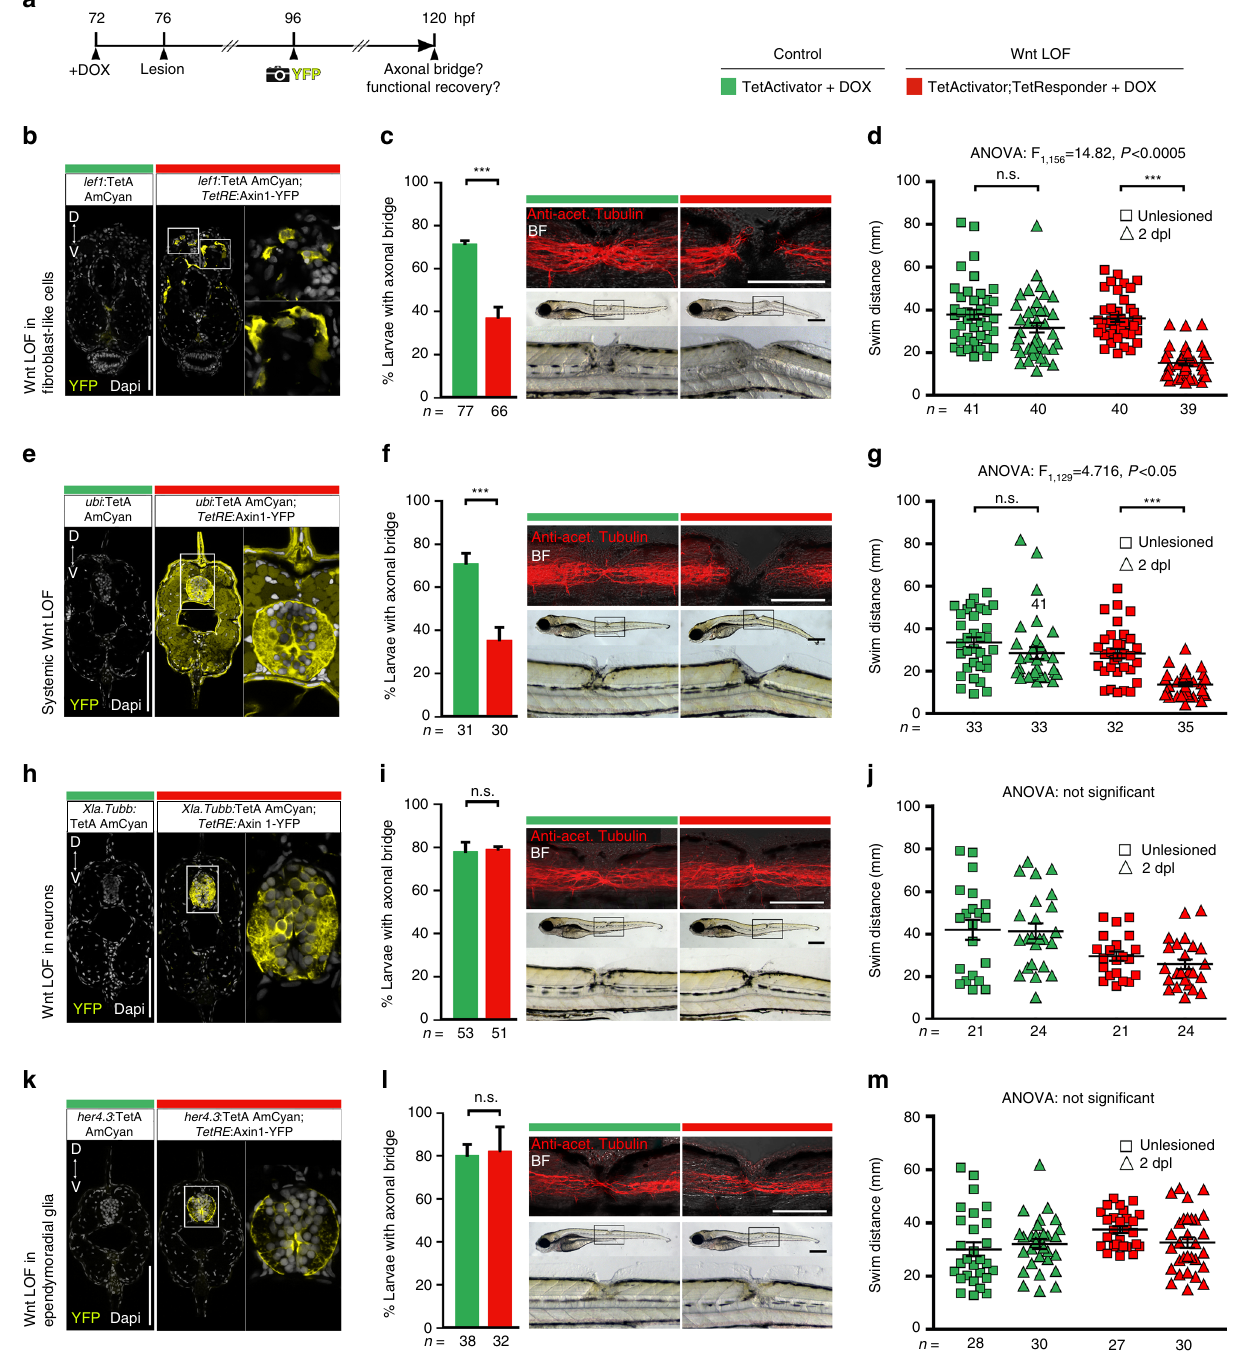
Fig. 3 Wnt/ β -catenin signaling in non-neural cells is required for axon regeneration and functional recovery. a Schematic timeline of the experimental design using the TetON system. b – d axin1 overexpression selectively in cells in the lesion site ( b ; lef1 + ) is suf fi cient to interfere with axon regeneration ( c ; Fischer ’ s exact test: *** P < 0.001) and functional recovery ( d ; two-way ANOVA: F 1,156 = 14.82, P < 0.0005; t -test: *** P < 0.001). e – g axin1 overexpression throughout the fi sh e interferes with axon regeneration ( f ; Fischer ’ s exact test: * P < 0.05) and functional recovery ( g ; two-way ANOVA: F 1,129 = 4.716, P < 0.05; t -test: *** P < 0.001). h – j Neuronal axin1 overexpression, indicated by YFP labelling of parenchymal cell bodies and neuropil in the spinal cord h , does not interfere with axon regeneration i or functional recovery ( j ; two-way ANOVA shows no interaction between lesion and treatment). k – m axin1 overexpression in ependymoradial glial cells, indicated by YFP labeling in cell bodies lining the central canal, their radial processes and pial end feet k does not interfere with axon regeneration l or functional recovery ( m ; two-way ANOVA shows no interaction between lesion and treatment). b – e Views are transversal ( b , e , h , k ; dorsal is up ) or lateral ( c , f , i , l ; dorsal is up , rostral is left ). BF: bright fi eld. n.s.: not signi fi cant. Scale bars : whole mounts, 200 and 100 µ m; sections: 100 µ m. Error bars indicate